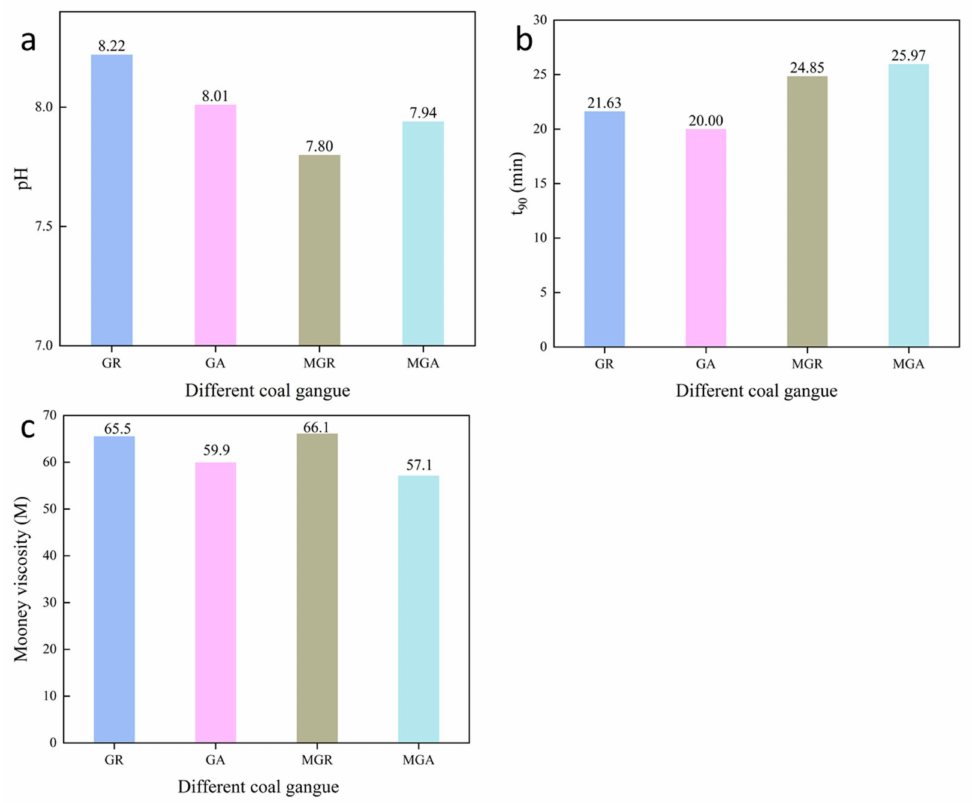
Figure 7. pH of coal gangue ( a ), t90 ( b ) and Mooney viscosity ( c ) of coal gangue/SBR